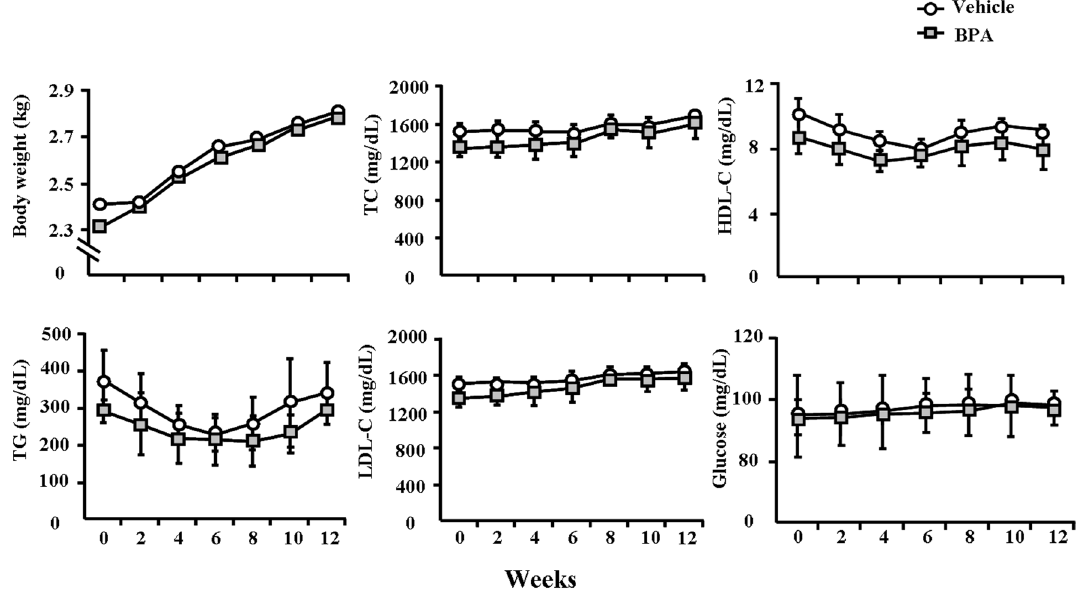
Figure 2. Body weights, serum lipids and glucose levels in WHHL rabbits over 12 weeks. These indexes were monitored every 2 weeks. Data are expressed as the means 6 SD, n=6 for each group.